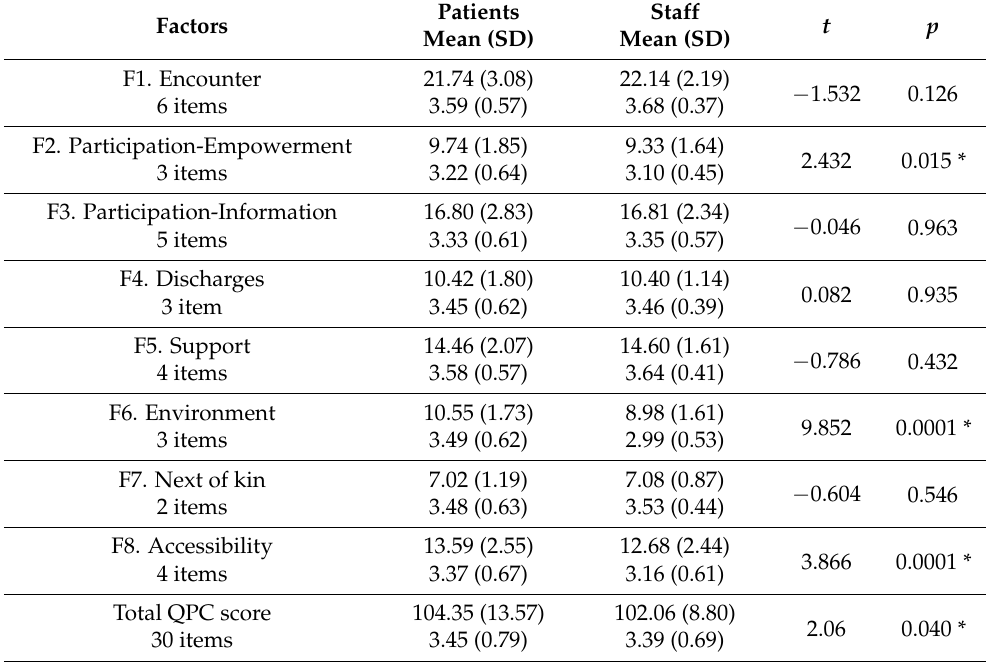
Table 2. Means (M) and Standard Deviations (SD) of Perceived Quality of Outpatient Care Among Patients and